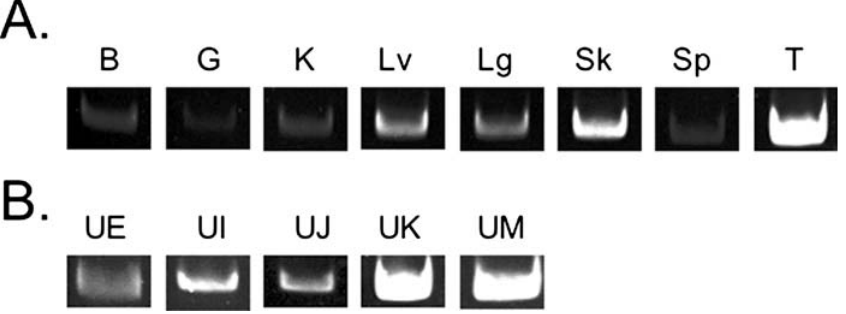
Figure 6. RT-PCR Results Demonstrating Class I Expression (A) RT-PCR results demonstrating Class I UA1 expression in brain (B), gut (G), kidney (K), liver (Lv), lung (Lg), skin (Sk), spleen (Sp), and thymus (T). (B) RT-PCR results demonstrating expression of Class I UE, UI, UJ, UK, and UM in the thymus. Similar results were found for UG (not shown). Controls (water) were negative for all primer combinations (not shown). DOI: 10.1371/journal.pbio.0040046.g006 PLoS Biology |